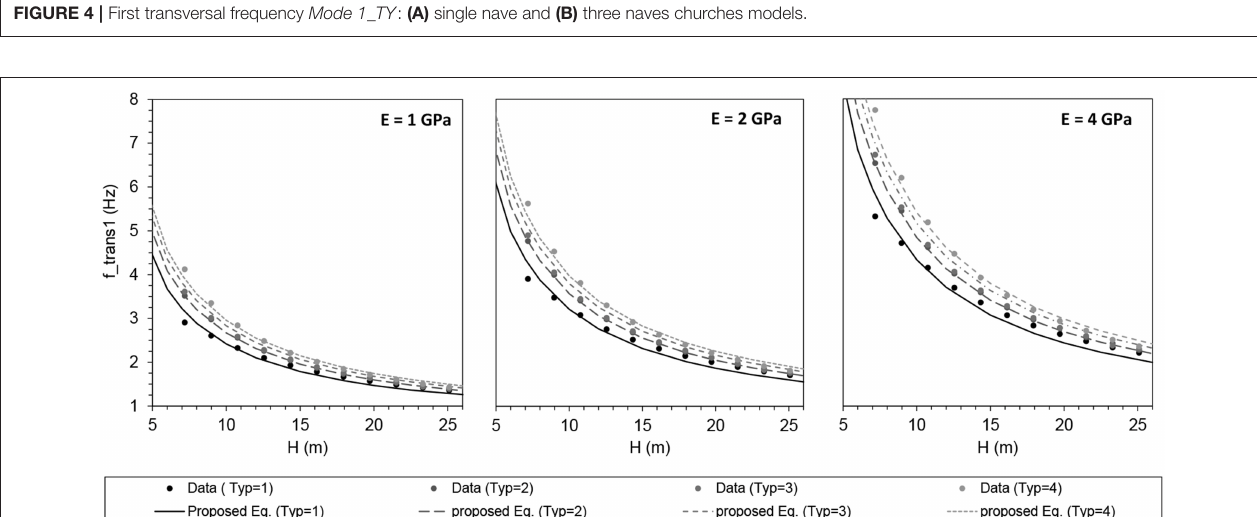
FIGURE 5 | First transversal frequency f_trans1 : comparison between the numerical data and the proposed equation in the case of single nave churches (1N-S).